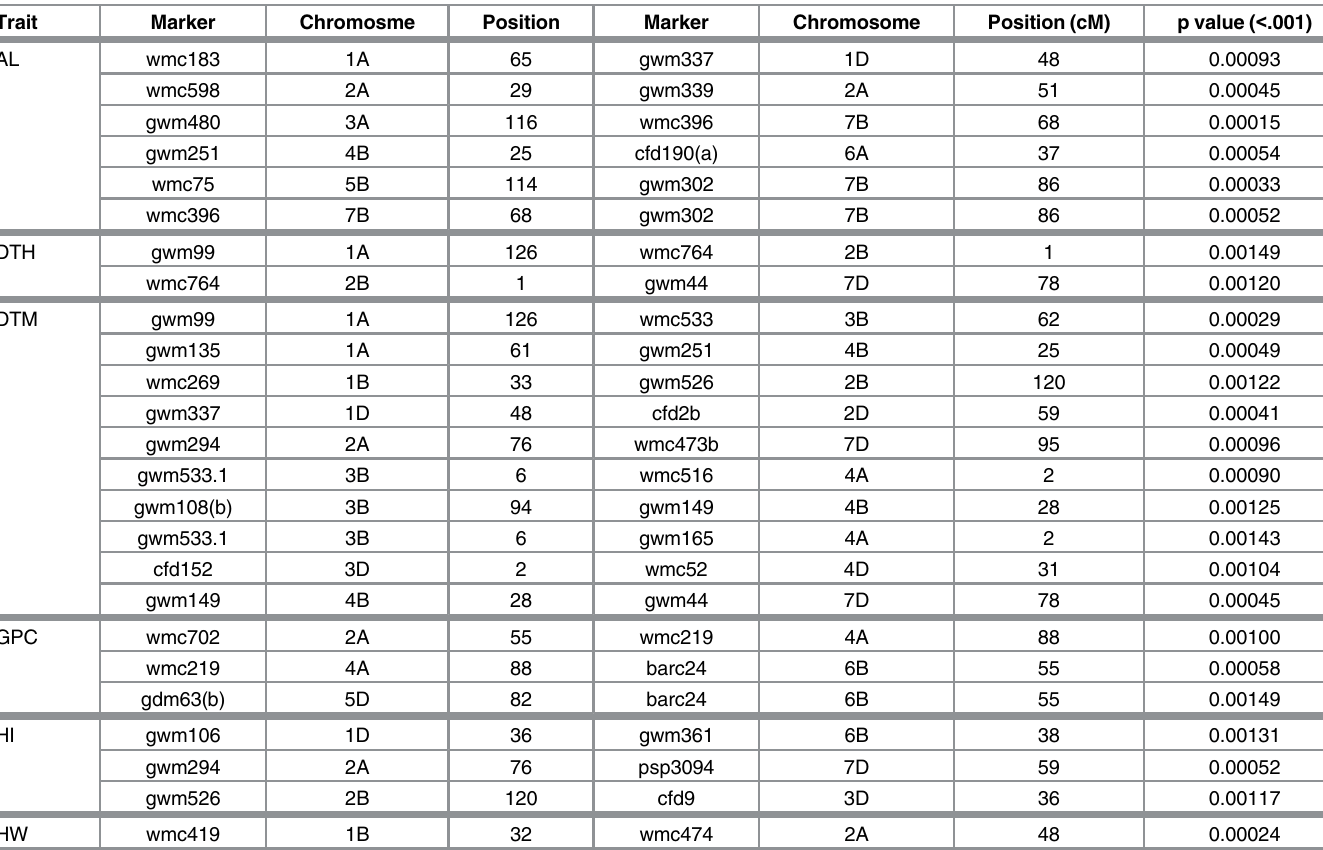
Table 6. Epistatic interactions using main effect markers (identified by SLST, MLMM and MTMM) for 13 traits along with their p-value.